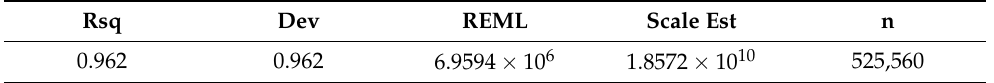
Table 8. Model summary table extended non-spatial GAM with a spatial covariate.